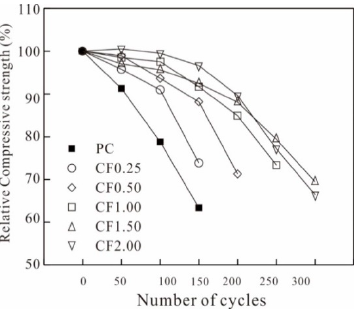
Figure 6. Effect of carbon fiber content on the compressive strength. CF, carbon fiber; PC, plain